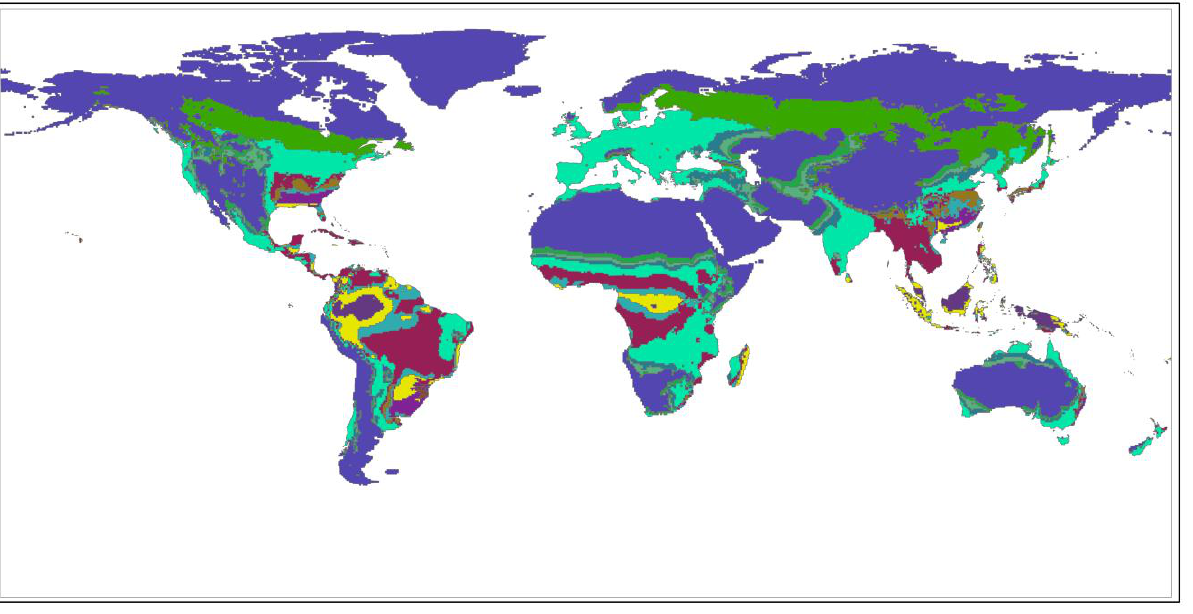
Figure 1. Distribution of Agro-Ecological Zones in the world.